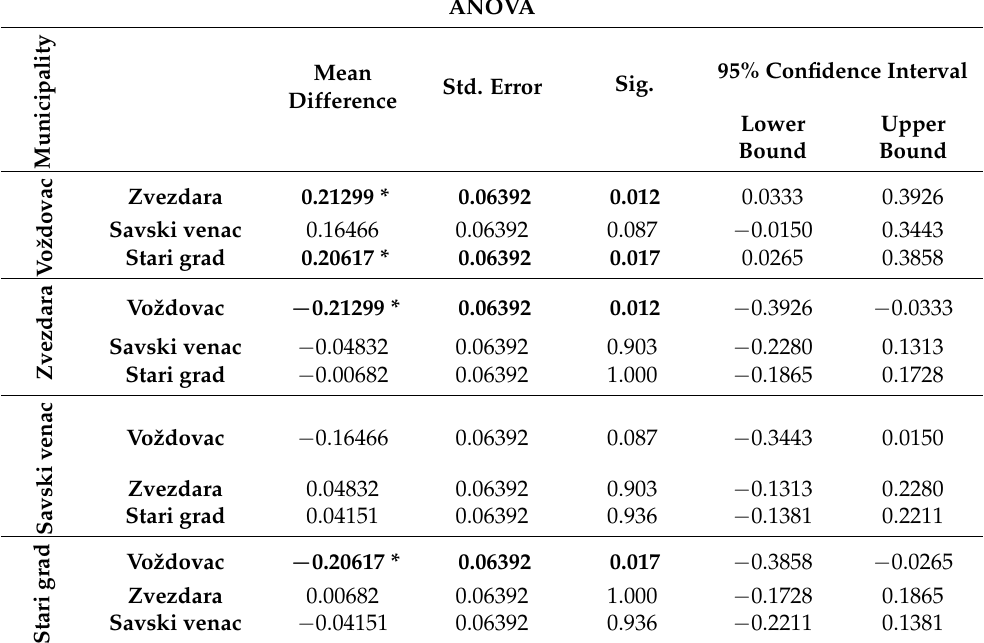
Table 7. Analysis of variance for the EVI values per